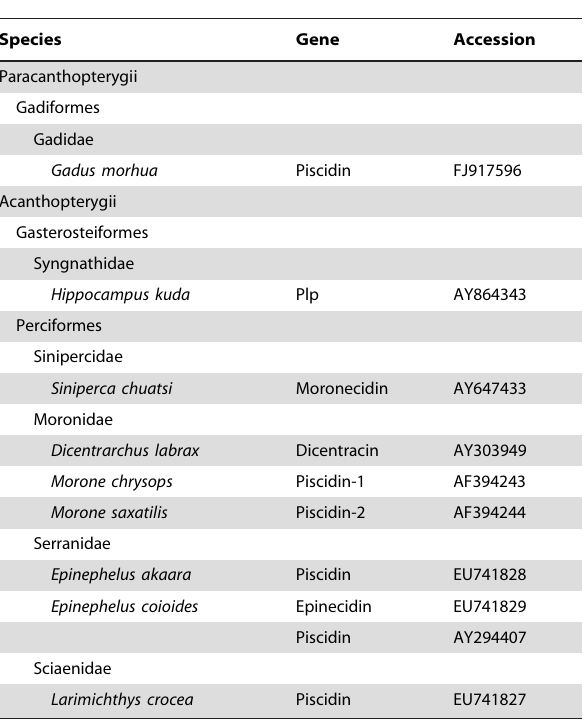
Table 1. Genbank accession numbers of piscidin